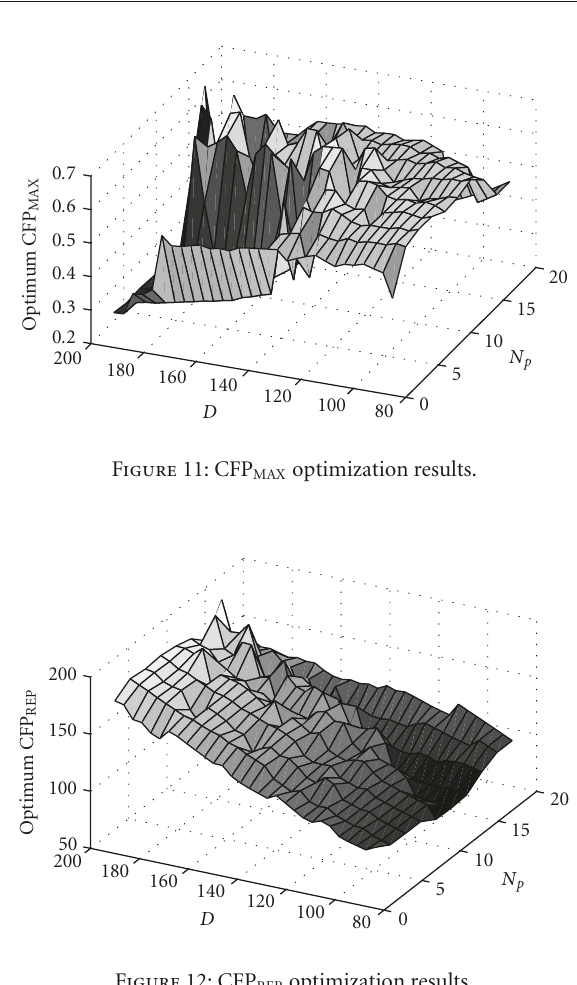
Figure 12: CFP REP optimization